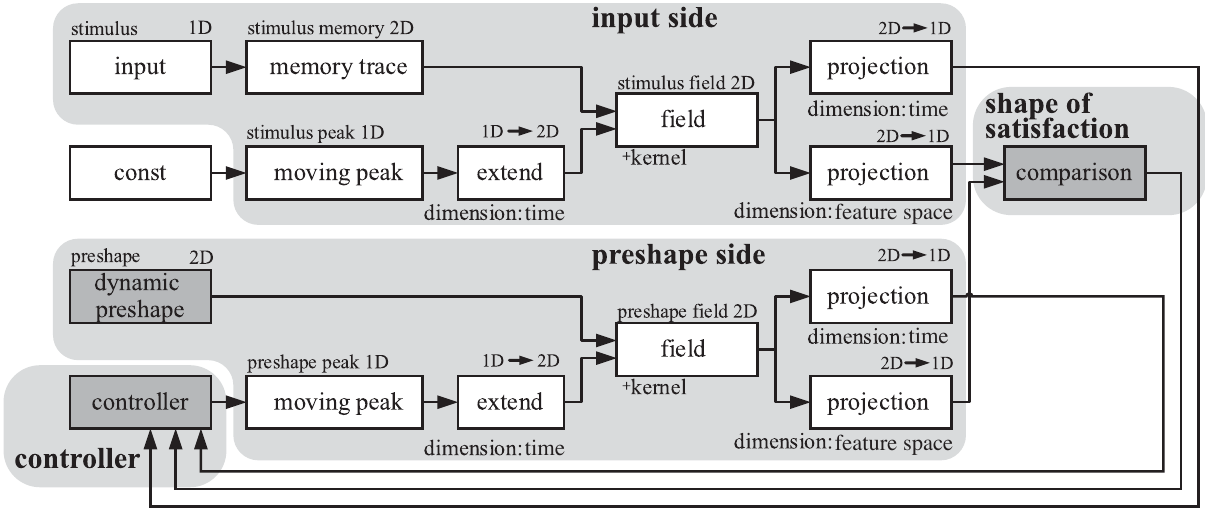
Figure 9. Overview of the trajectory action recognition module. Dark grey blocks represent blocks that are explained in detail in separate sections. Feedback signals are given to the controller from projection fields and the comparison field.